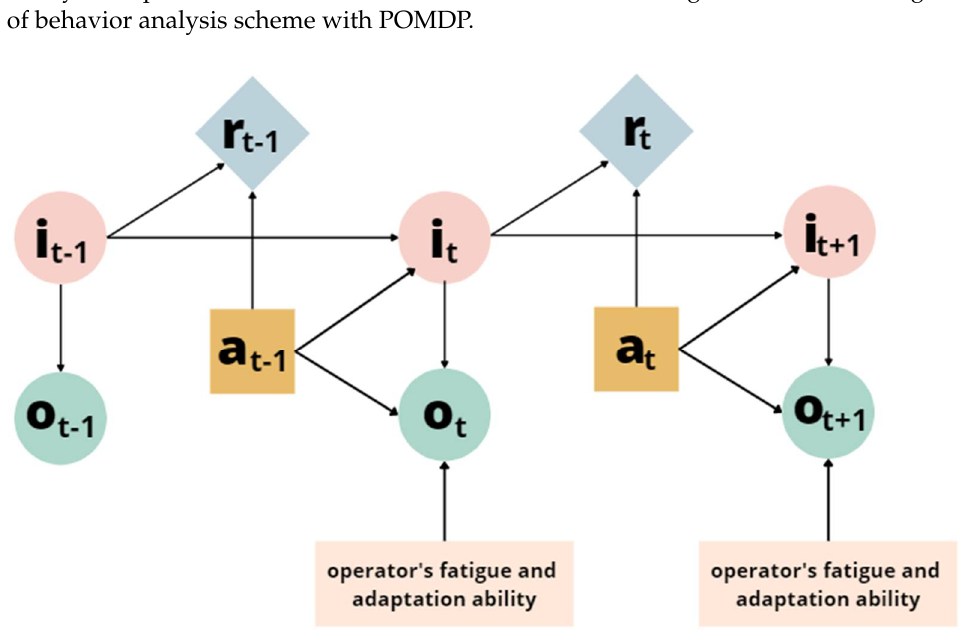
Table 5. Reward in the proposed system.